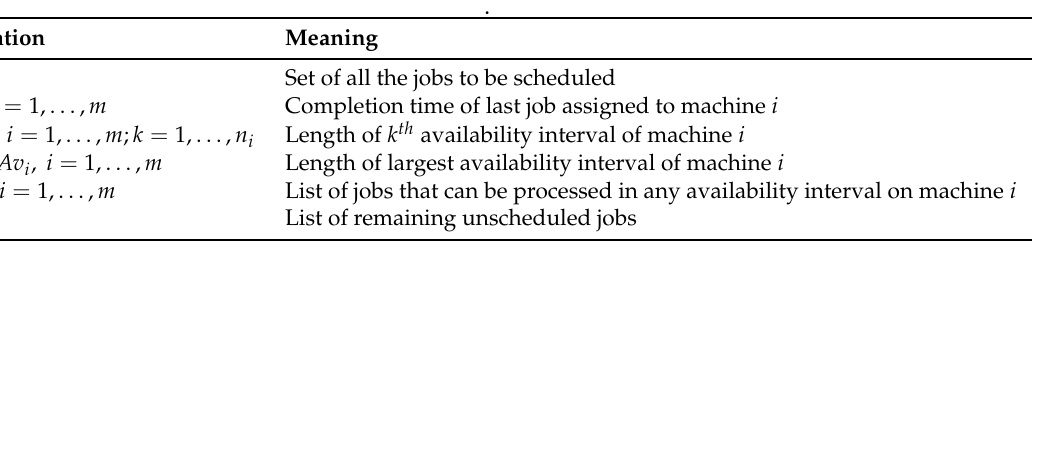
Algorithm 2. Table 1 lists notations used to develop Algorithms 1 and 2. Table 1. Notations used in Algorithms 1 and